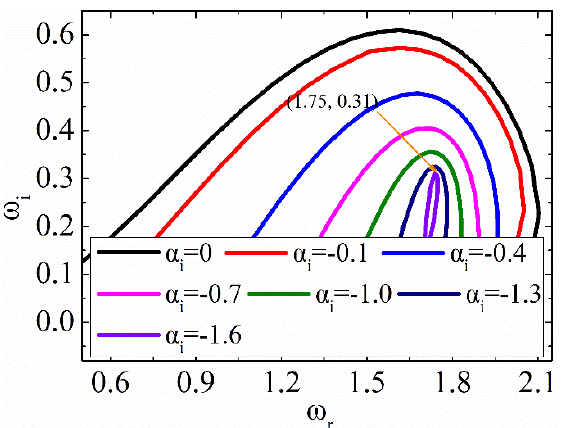
 Figure 13. Map of lines α i = constant in the plane, at X/B = 0.08 for the case J sj = 0. Figure 13. Map of lines i = constant in the plane, at X/B = 0.08 for the case J sj = 0. The ω i at various locations behind the SBG model with and without trailing  at various locations behind the SBG model with and without trailing edge The i